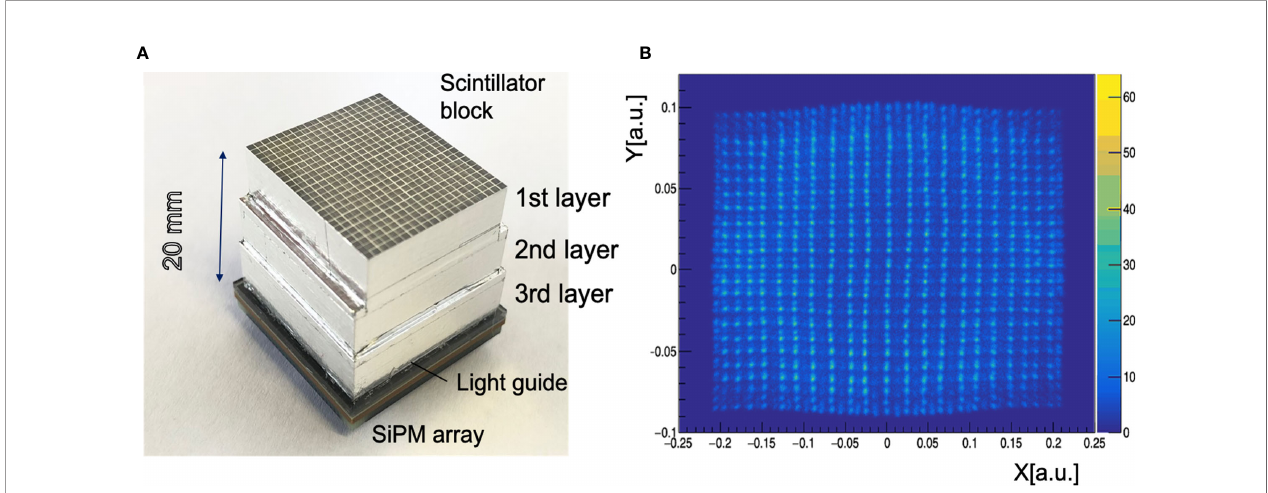
FIGURE 6 | LMU hybrid g -PET detector (A) A 3-layer PET detector developed at LMU Munich in collaboration with NIRS-QST. The PET detector consists of a 3-layer scintillator block, a light guide and an 8 × 8 SiPM array. (B) A fl ood map of the 3-layer PET detector exposed to a 22 Na radioactive point